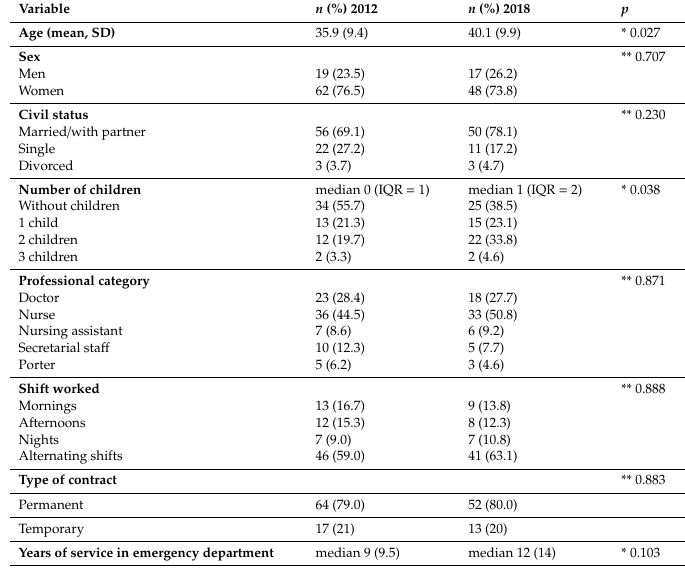
Table 1. Sociodemographic and occupational variables of the emergency service professionals ( n =